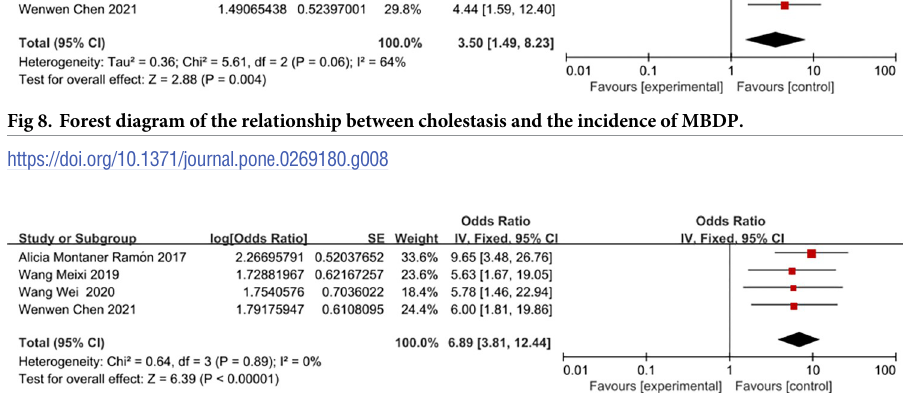
Fig 9. Forest diagram of the relationship between intrauterine growth retardation and the incidence of MBDP. https://doi.org/10.1371/journal.pone.0269180.g009 Table 5. Sensitivity analysis and publication bias